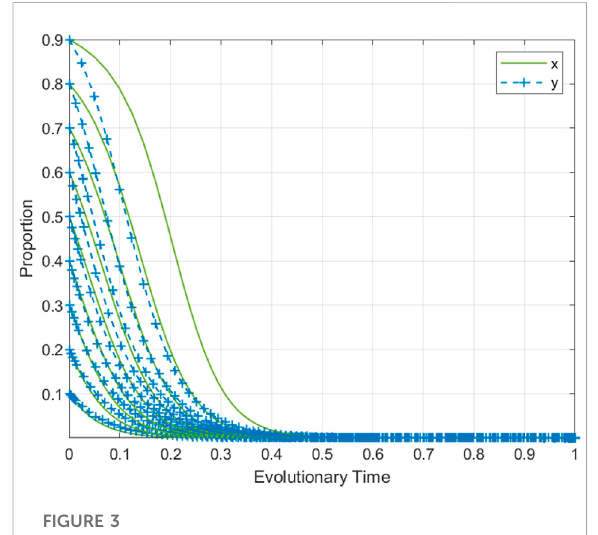
FIGURE 3 Simulation results of scenario one evolution.